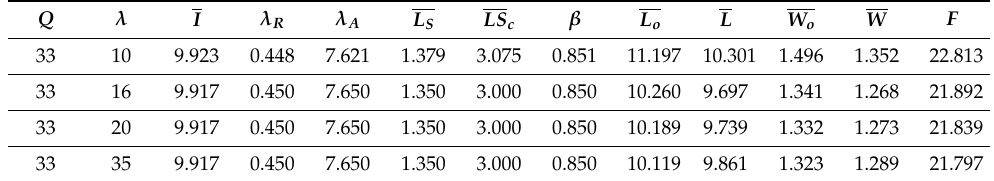
Table 8. The effect of µ on performance measures at Q = 33.